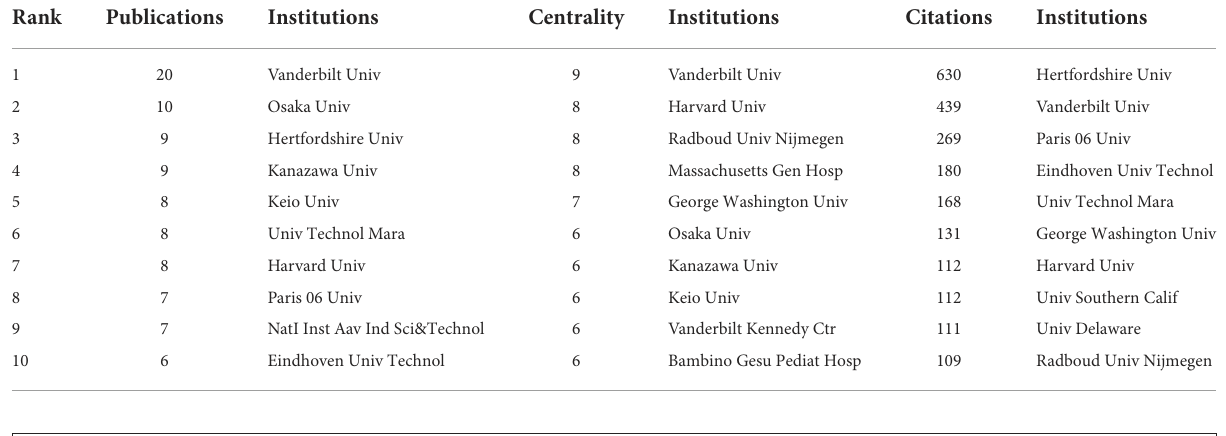
TABLE 4 Top 10 publications, centrality, and citations of institutions related to AI on ASD.